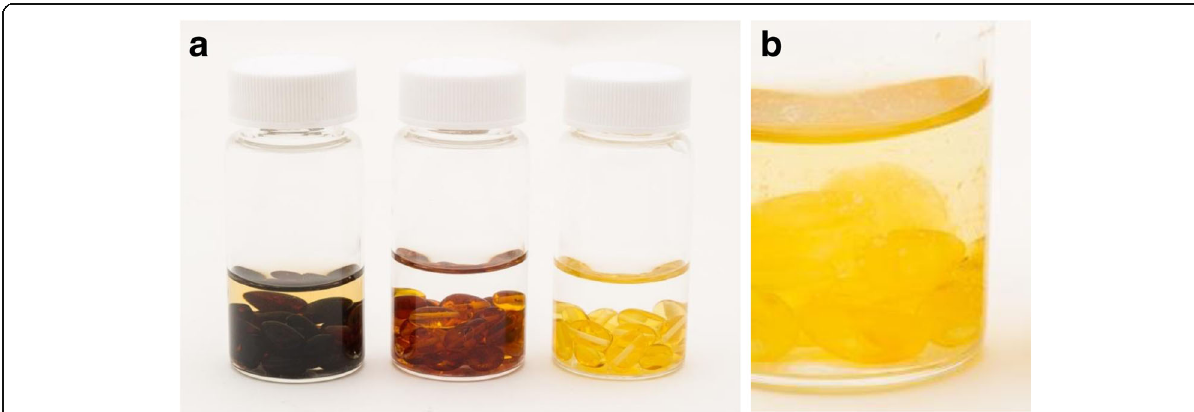
Fig. 3 Incubation of amber beads under various biologically relevant conditions. a Beads were removed from necklaces and sorted into colour variants, then stored at 37 °C in either pH 5.5 PBS or octanol for 6 months. Bead supernatants were periodically collected and succinic acid content was analysed by HPLC. b Succinic acid was only detected in the supernatant of light-coloured beads stored in octanol, in which one